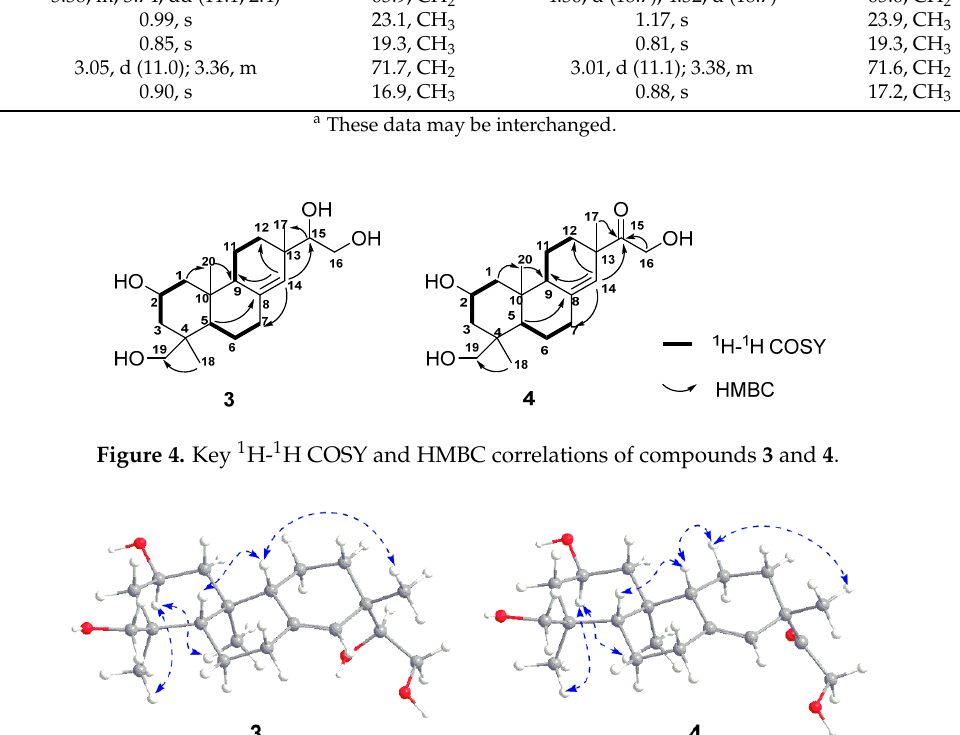
17.2, CH 3 a These data may be interchanged. All the new compounds were tested for their cytotoxic activity on human cervical cancer Hela cells, human lung cancer A549 cells, and human breast cancer MCT-7 cells. The MTT assay results showed compounds 3 and 4 significantly inhibited proliferation on three cell lines at the concentration of 10 μ M. The inhibitory rates for compounds 3 and 4 were 60.7% ± 1.9% and 62.6% ± 1.6% on Hela cells, 26.4% ± 4.1% and 29.0% ± 1.1% on A549 cells, and 41.2% ± 1.4% and 44.7% ± 1.9% on MCF-7 cells, respectively. However, compounds 1 and 2 did not show obvious cytotoxicity at 20 μ M against the three cell lines. Herein, paclitaxel was used as the positive control, and the inhibitory rate of paclitaxel (200 nM) on Hela, A549, and MCF-7 cells were 56.2% ± 5.4%, 66.7% ± 8.8% and 43.3% ± 8.1%, respectively. Additionally, the new compounds were evaluated for their inhibitory effect on NO production in LPS-stimulated RAW264.7 cells. The results showed compounds 2 and 4 significantly reduced NO production, with IC 50 values of 26.5 ± 6.1 and 17.1 ± 1.5 μ M,